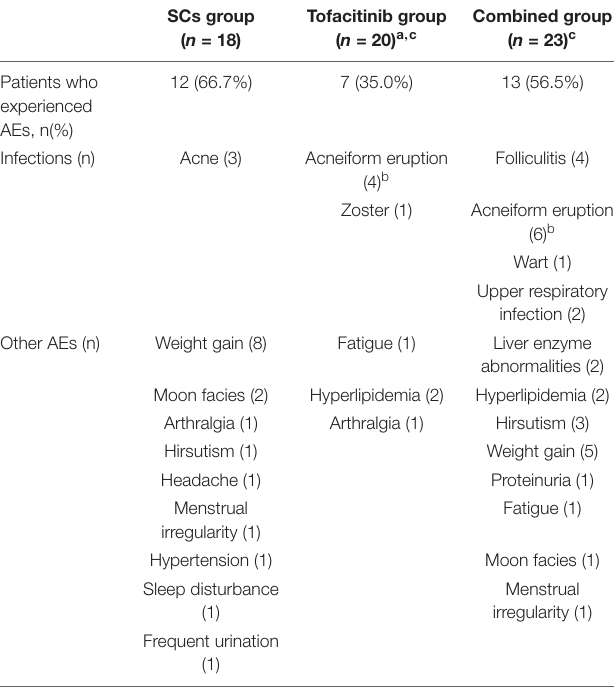
TABLE 2 | AEs observed in each